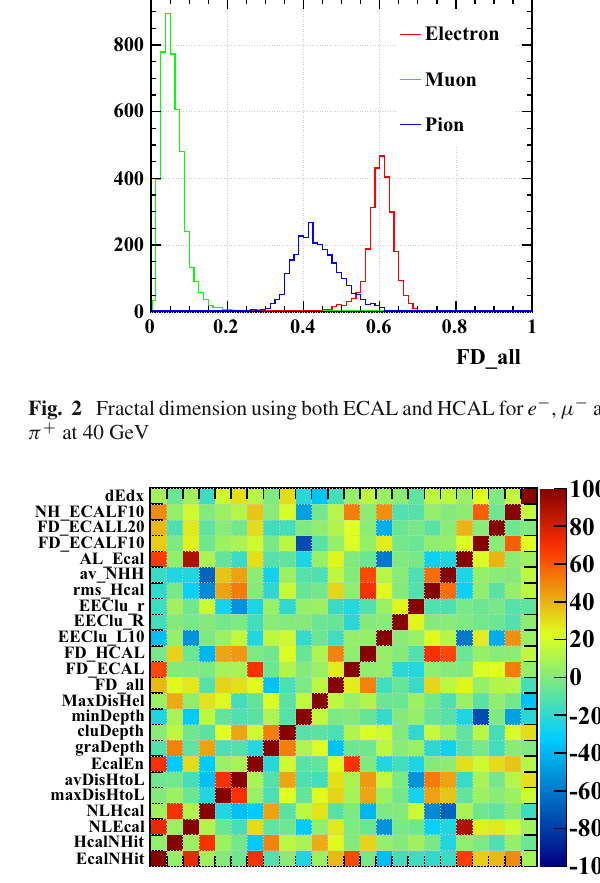
Fig. 3 The correlation matrix of all the